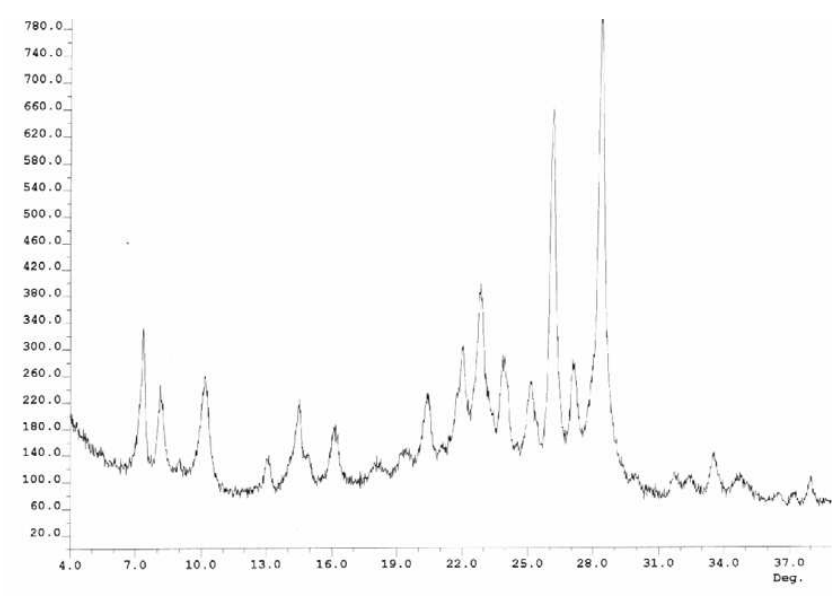
Fig. 2 The XRD pattern of MCM-22 containing the complex after